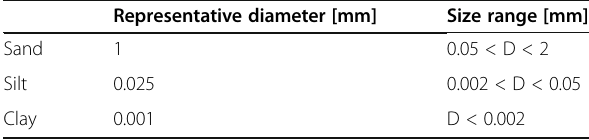
Table 1 Representative diameter of three sediment